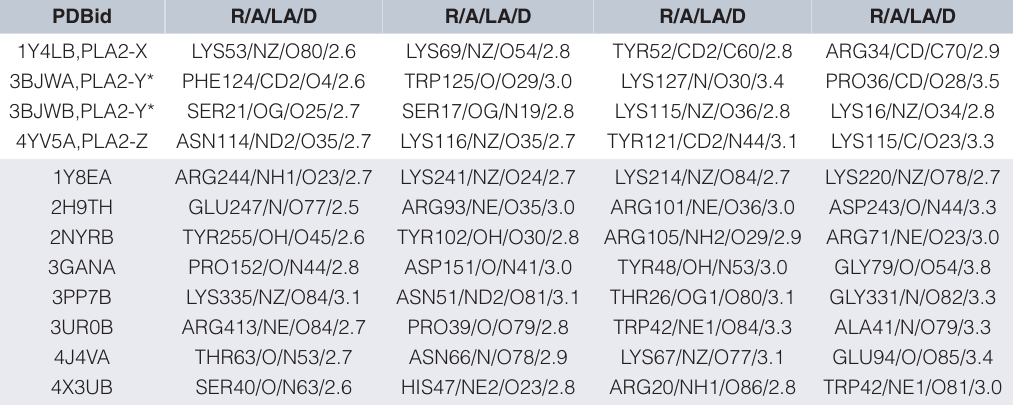
Table 8. Suramin binding residues in nine non-homologous proteins from the PDB database: Interactions sorted based on the distance. R/A/LA/D: Residue number/Atom of the residue/Atom of ligand/distance between the interacting atoms (in Å). For example, ‘LYS53/NZ/O80/2.6’ means that the atom NZ from Lys53 is at 2.6 Å from the O80 of the suramin drug in PDBid:1Y4LB. The non-specific binding of suramin to phospholipase A2-like proteins (PLA2) is demonstrated by different binding sites for the homologous PLA2-X and PLA2-Z. Also, suramin binds to different sites even within the homologous subunits of PLA2-Y (marked with